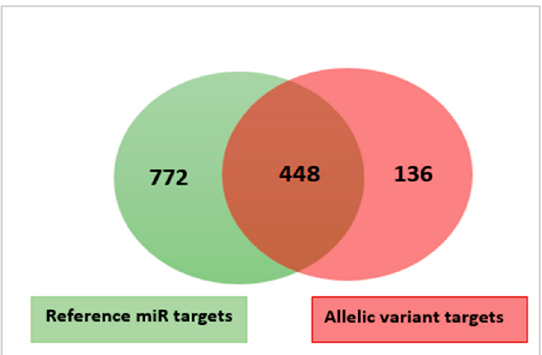
Figure 4. A Venn diagram illustrating the overlap and difference between the predicted target genes of the five reference mature miRNAs (green color) and the new mature miRNA variants identified in this study (light red color).